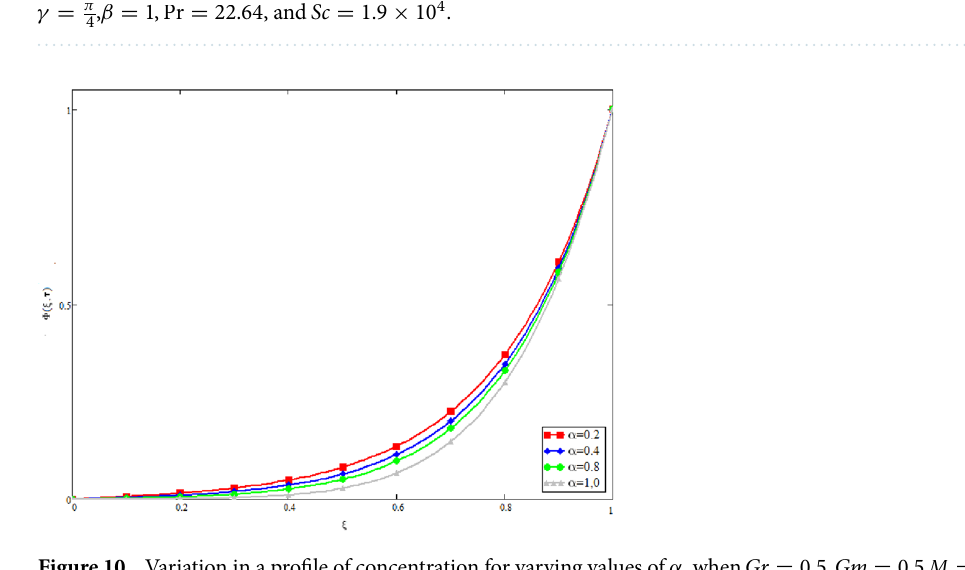
π β 22.64 , and Sc 1 , Pr 4 , = = =